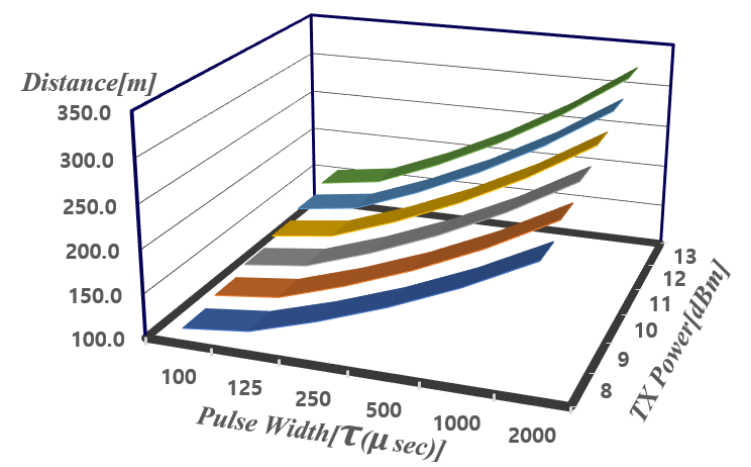
Figure 1. Radar detection distance ( R max ) according to transmit power and pulse width ( τ